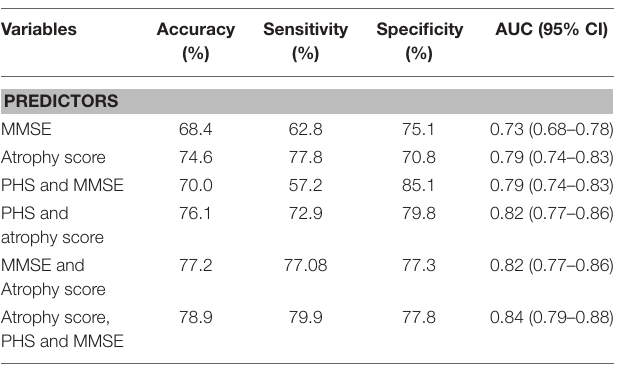
TABLE 3 | Prediction accuracy.